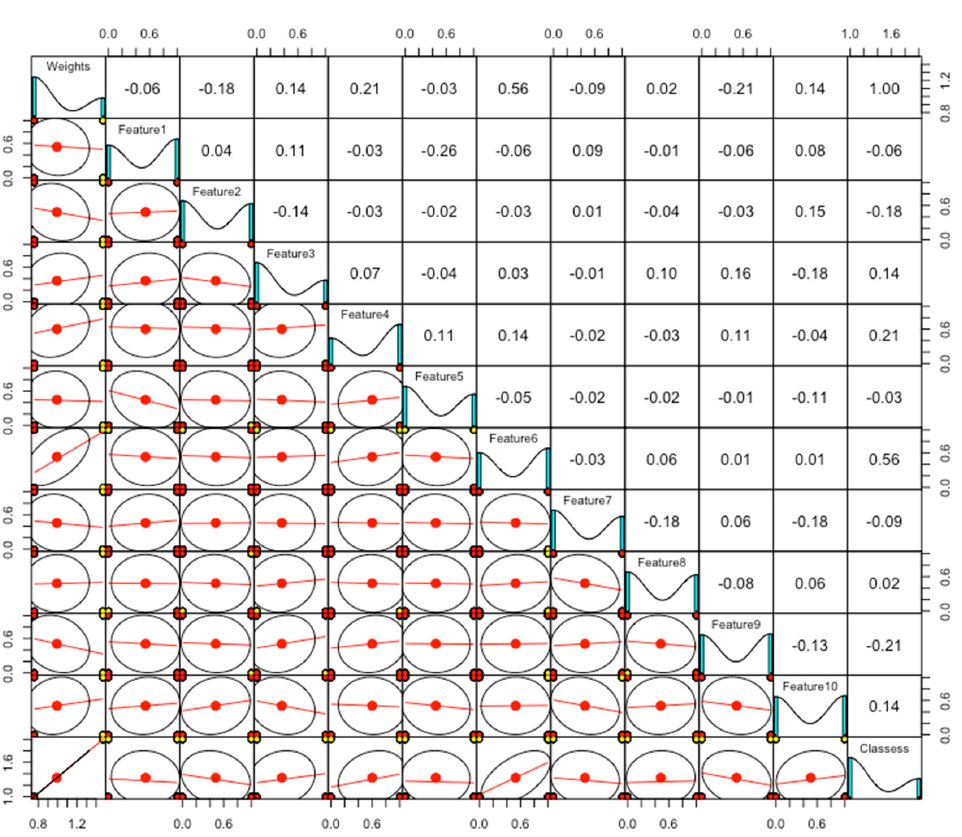
Figure 6. The Principal Components from balanced features set.